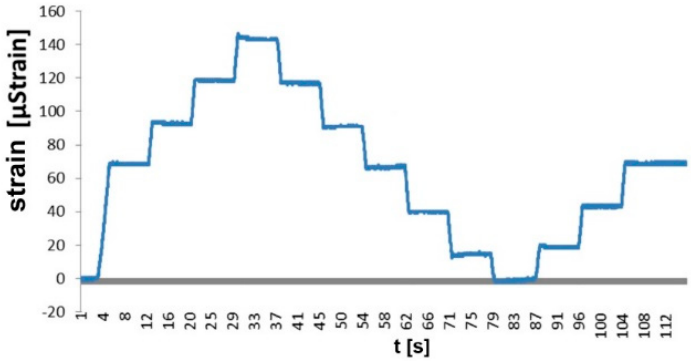
Figure 3. Calibration of the optical fiber transducer on the strength-testing machine.